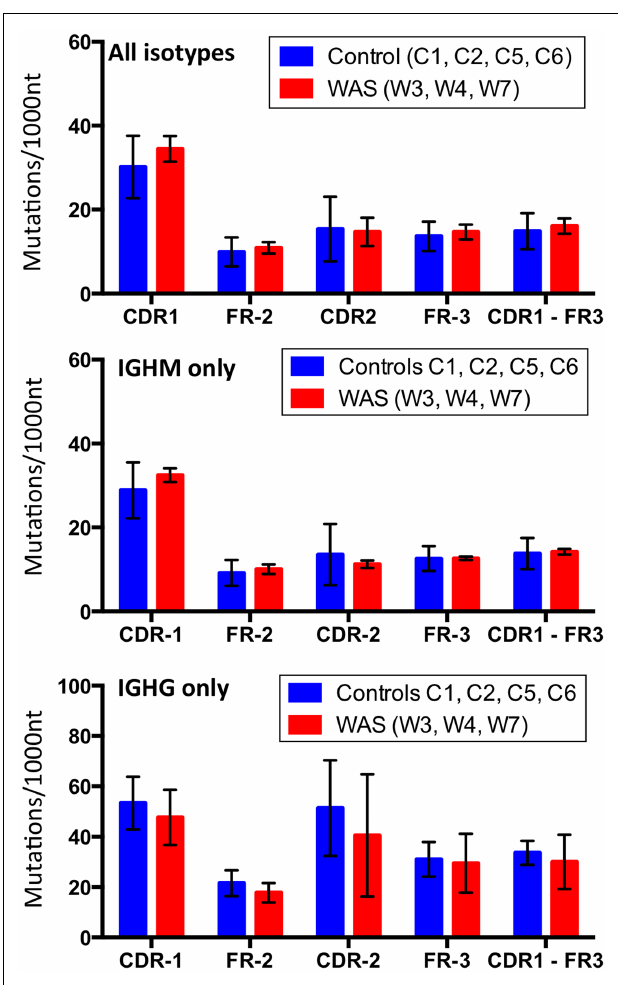
FIGURE 14 |Analysis of somatic hypermutation .The rate (per 1,000 nucleotides) of somatic hypermutation in complementarity determining regions (CDR) and framework regions (FR) is shown for controls andWAS patients. Bars indicate the mean ±